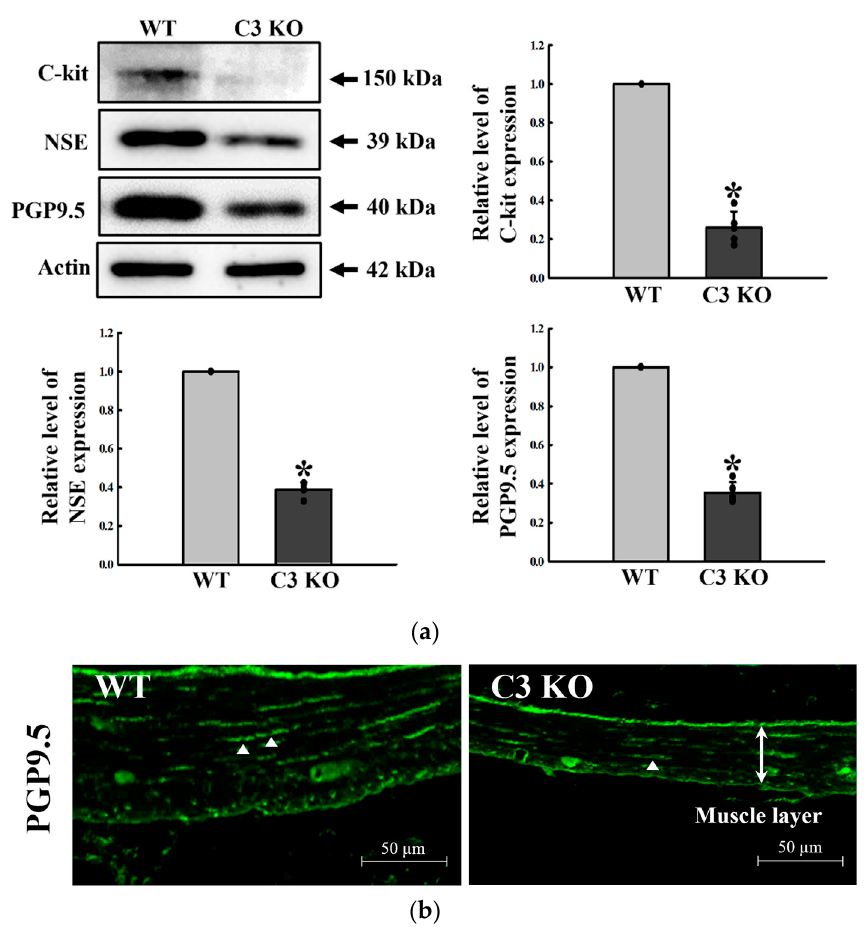
Figure 2. Expression levels of C-kit, NSE, and PGP9.5 in the mid colon of C3 KO mice. ( a ) Expression levels of C-kit, NSE, and PGP9.5 proteins. The expression level of the three proteins was determined by Western blot analysis using the specific primary antibody and HRP-labeled anti-rabbit IgG antibody. The band intensities were determined using an imaging densitometer, and protein expressions were calculated relative to the intensity of 𝛽 -actin. Four mice per group were used to prepare the tissue lysates, and Western blots were assayed in duplicate for each sample. Data are reported as the mean ± SD. * p < 0.05 compared with the WT group. ( b ) Tissue distribution of PGP9.5 proteins. This level was detected in the mid colon using an immunofluorescence (IF) staining assay. Three mice per group were used in the slide section, and IF staining was assessed in duplicate in two different slides. Arrowheads indicate PGP9.5-stained subpopulations. Abbreviations: WT, wildtype; KO, knockout; C-kit, receptor tyrosine kinase; NSE, neuron-specific enolase; PGP9.5, protein gene product 9.5; HRP, horseradish peroxidase; IgG, immunoglobulin G.